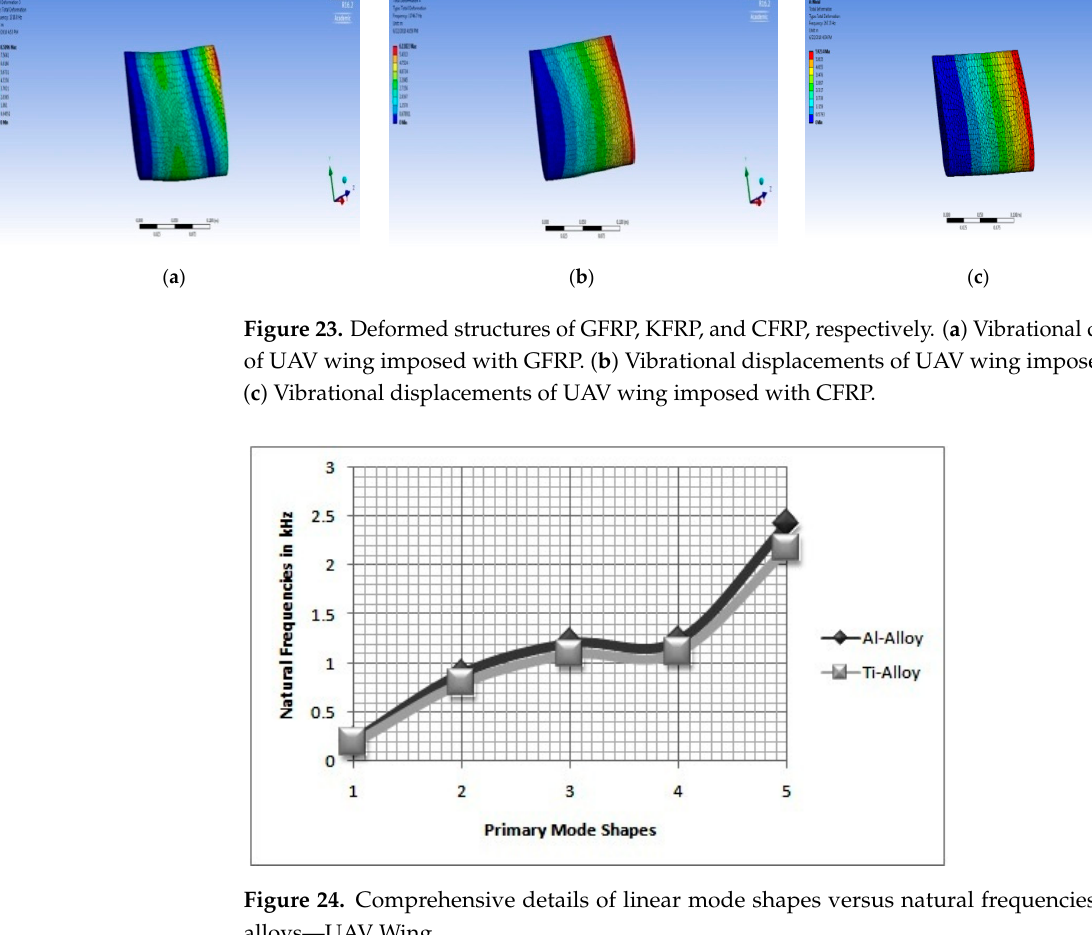
Figure 22. Comprehensive details of linear mode shapes versus natural frequencies for different composites—Wind Turbine Blade.